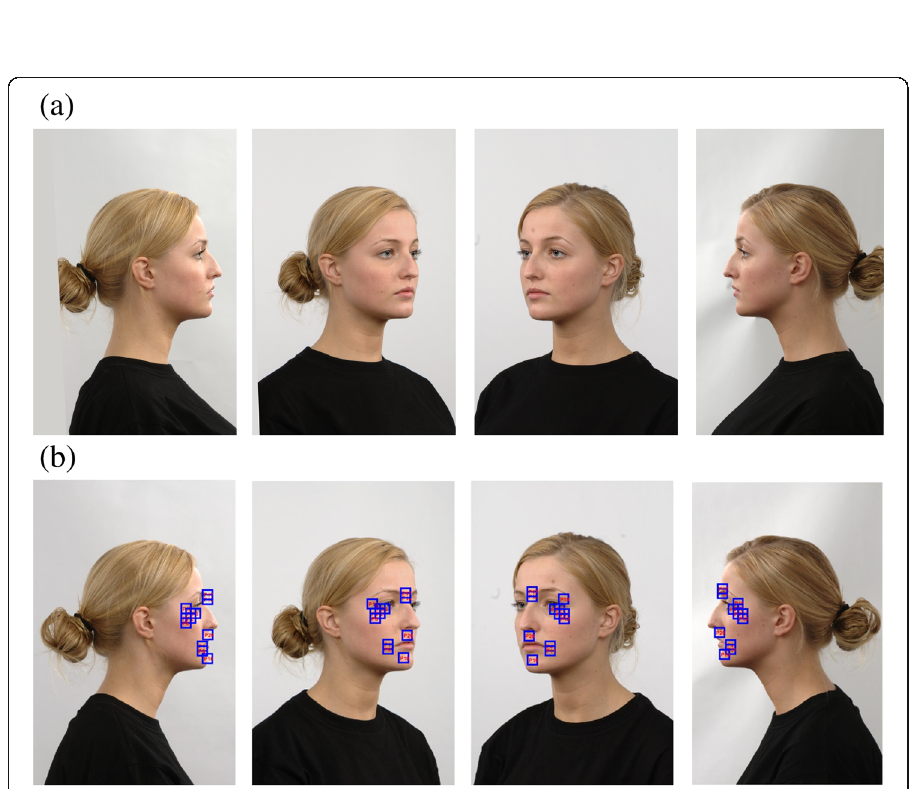
Fig. 3 Positions of salient facial patches under head pose variations. a Four face images with different head poses (left to right: 90°, 45°, − 45°, and − 90°), and b positions of the salient facial patches in the corresponding face